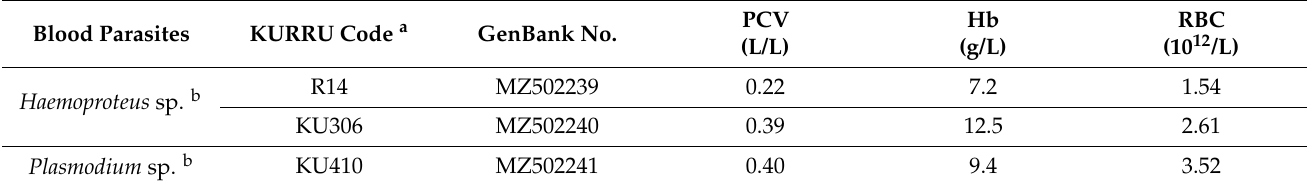
Table 1. Summary of blood parasites in rufous-winged buzzards and some hemograms in para- sitized